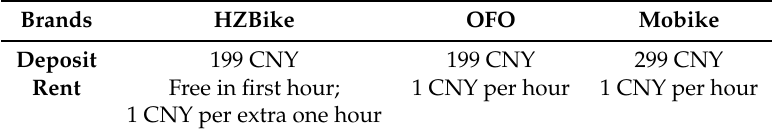
Table 4. Price comparison among three brands.